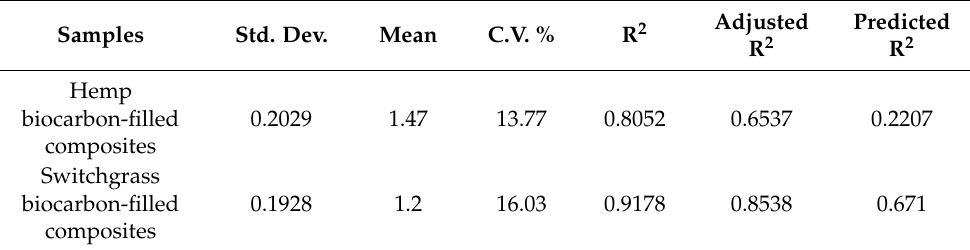
Table 3. Fit Statistics (the predicted R 2 against the adjusted R 2 ) for the Full Model of biocarbon-filled hemp reinforced polymer composites.